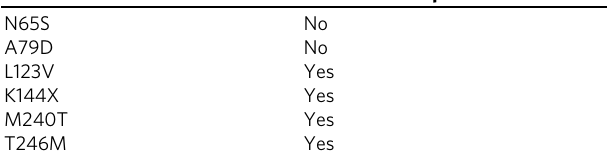
Table 1 Ataxia-related Stub1 mutants tested. Disease-related Stub1 mutations Localizes onto